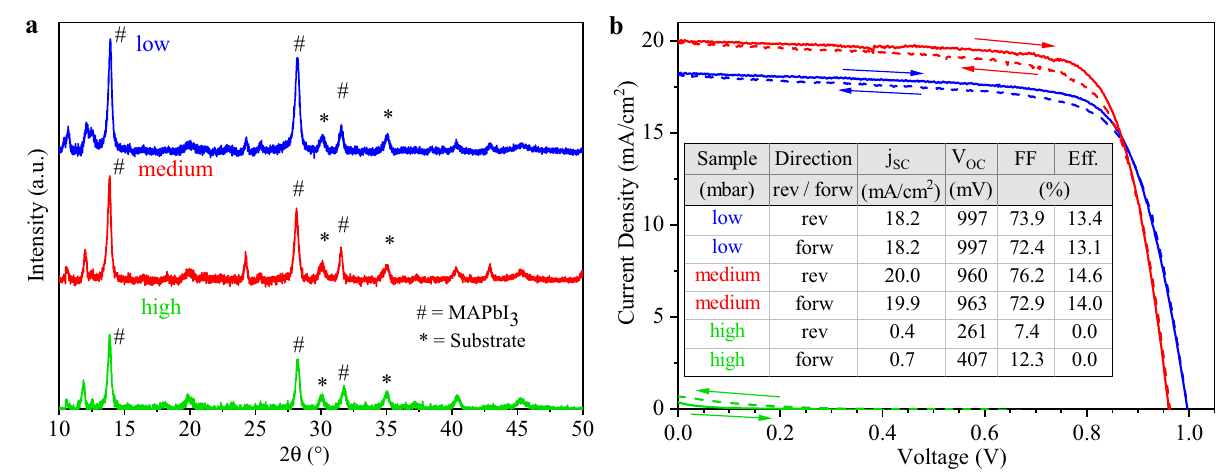
Figure 4. ( a ) XRD scans of the pristine MAPbI 3 layers prepared at different chamber pressures. (110), (220) and (222) peaks for MAPbI 3 are indicated by a sharp (#) at 13.9 are labeled with an asterisk ( ∗ ). ( b ) Current–voltage characteristics for champion cells fabricated at different chamber pressures recorded at 15